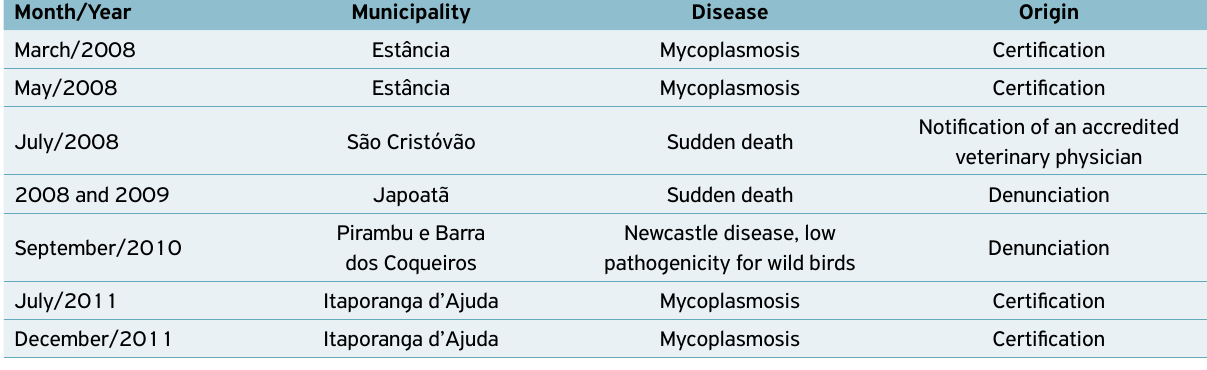
Table 6. Notifications of poultry diseases in municipalities of Sergipe,